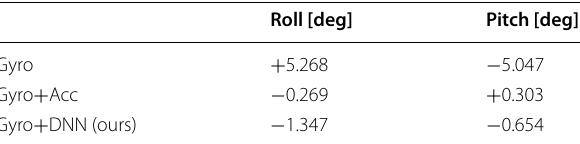
Table 8 Error of estimated attitude at last pose in outdoor experiment